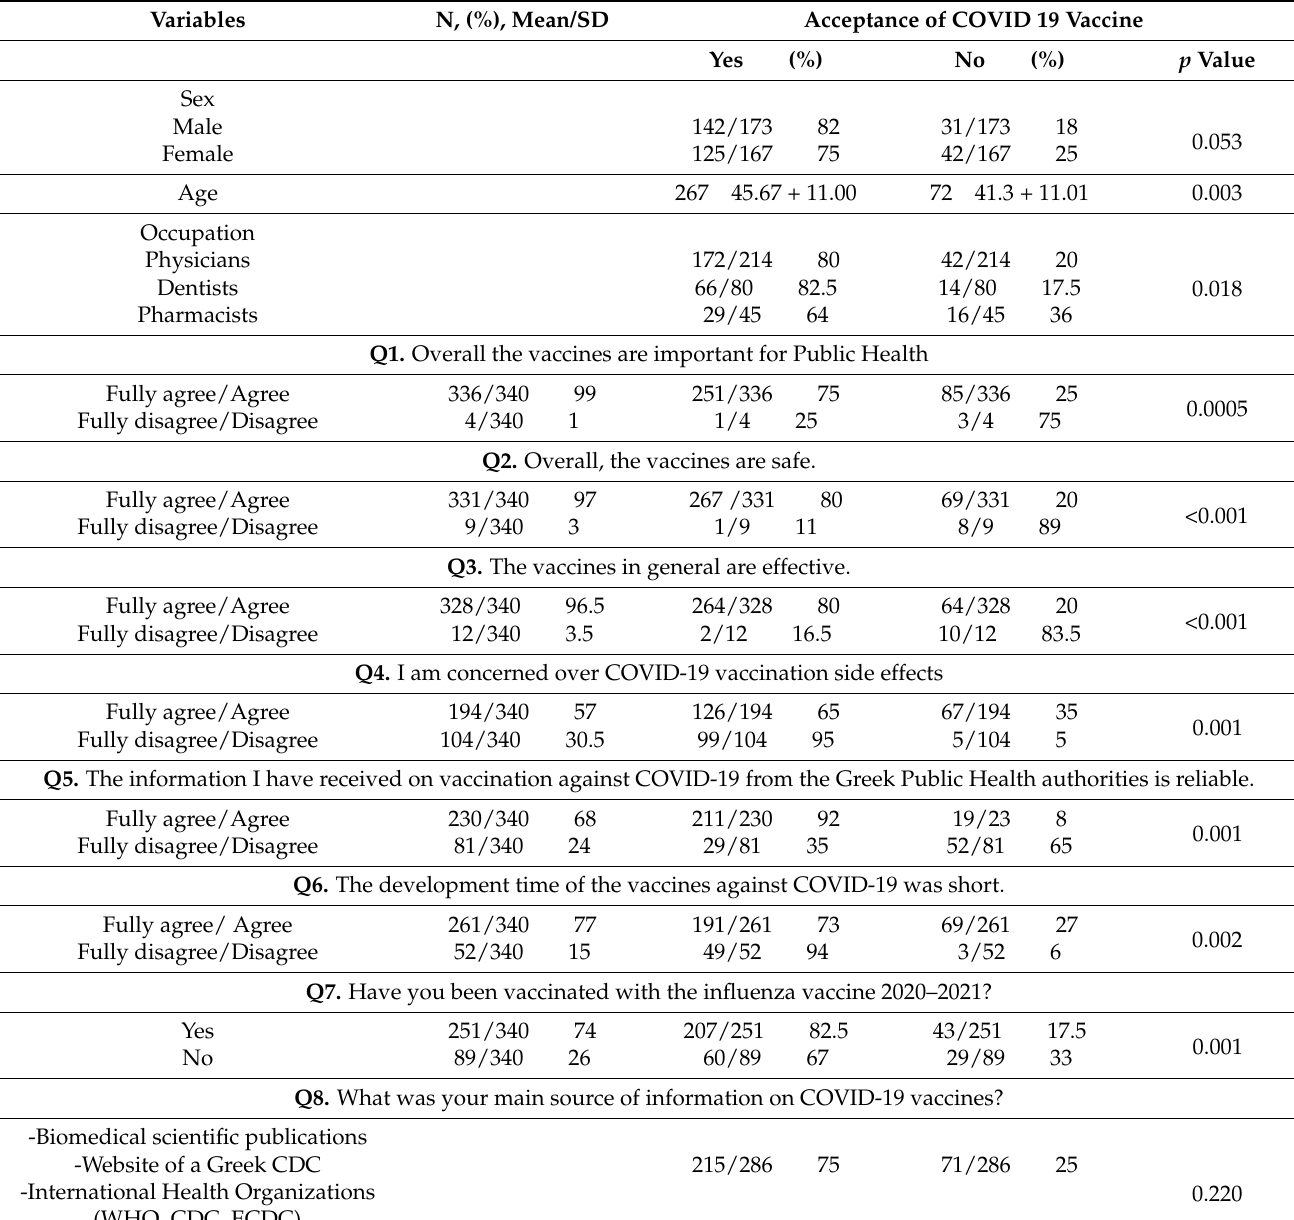
Table 2. Univariate analysis of Covid-19 vaccination